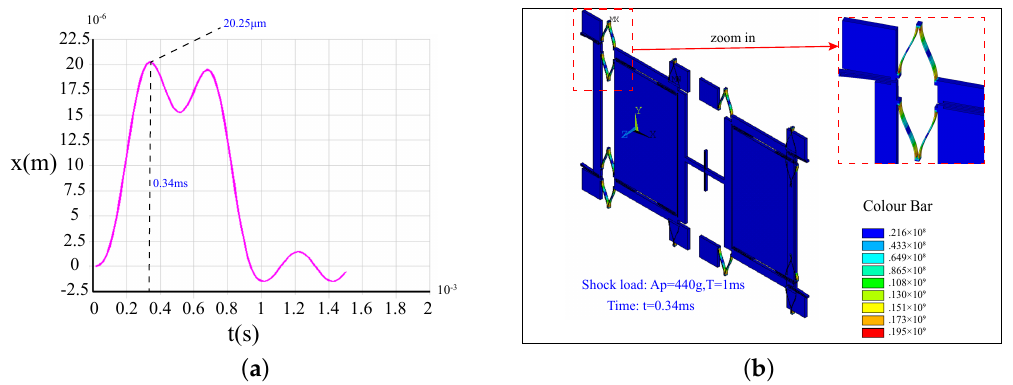
Figure 18. The shock response ( a ) and the stress distributions ( b ) at the maximum impact displacement of Type-A under a 440 g shock load.